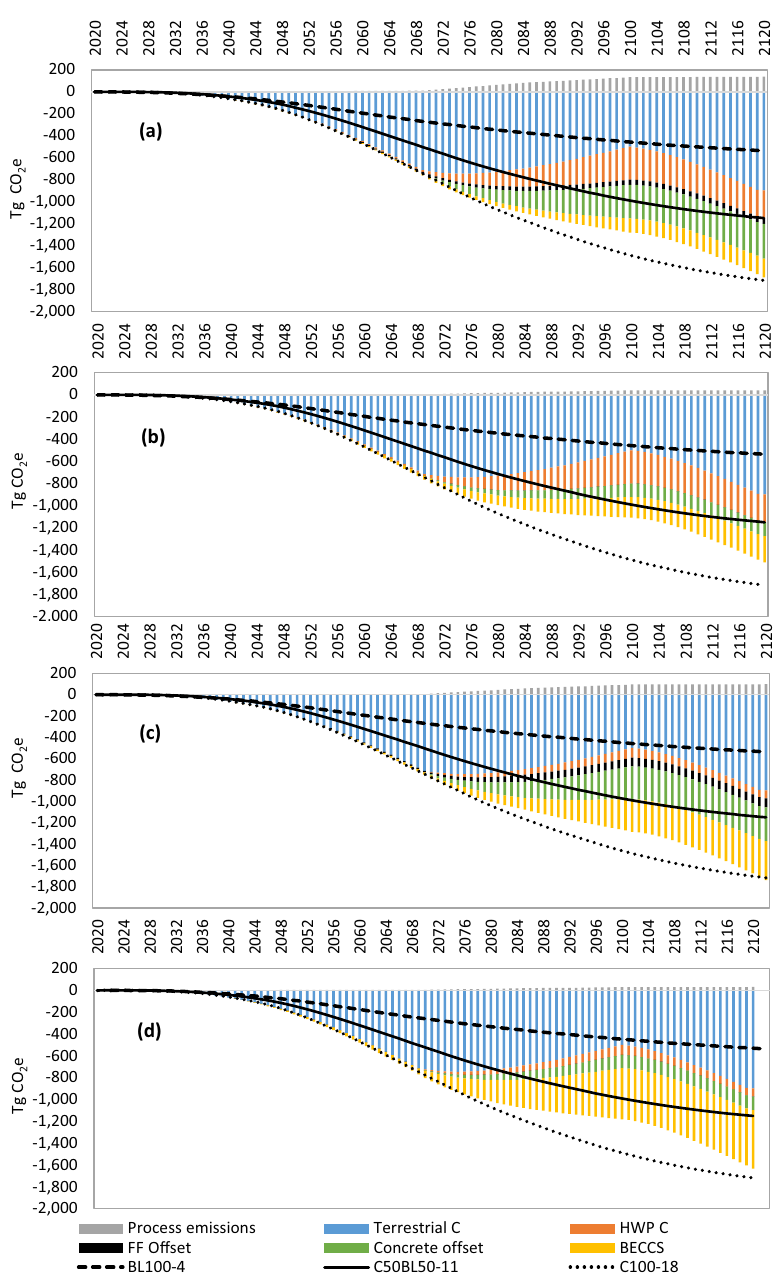
Fig. 2 Cumulative CO 2 e mitigation over a 100-year period for commercial forests planted at a rate of 30,000ha year − 1 from 2020 to 2050, with a Hierarchical wood use strategy (a, b) or a Bioenergy wood use strategy (c, d), under Core (a, c) or Further Ambition (b, d) decarbonisation contexts. Commercial Sitka spruce forests are modelled based on default yield class (YC) 18. Contributing factors are shown as stacked bars: process emissions, terrestrial forest carbon storage, harvested wood product (HWP) carbon storage, fossil fuel (FF) substitution (negligible in the Further Ambition context), concrete substitution and bioenergy carbon capture and storage (BECCS). Also shown (lines) are cumulative CO 2 e mitigation trends for conservation forests planted at the same rate, ranging from semi-natural 100% broadleaf (YC 4), through a 50:50 mixed conifer:broadleaf forest (YC 11) to an unharvested 100% conifer forest (YC 18). These lines represent terrestrial forest carbon storage only, and the C100-18 forest provides a direct comparison of cumulative mitigation that could be achieved by YC 18 conifers if they are not